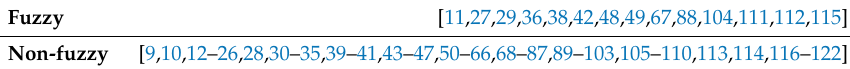
Table 2. Studies by fuzzy conditions.